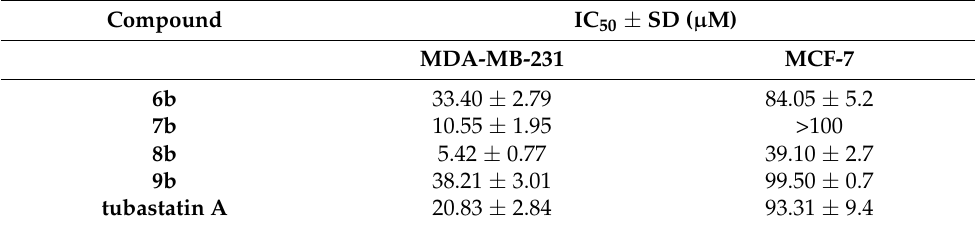
Table 3. Cytotoxic activities toward MDA-MB-231 and MCF-7 cell lines.